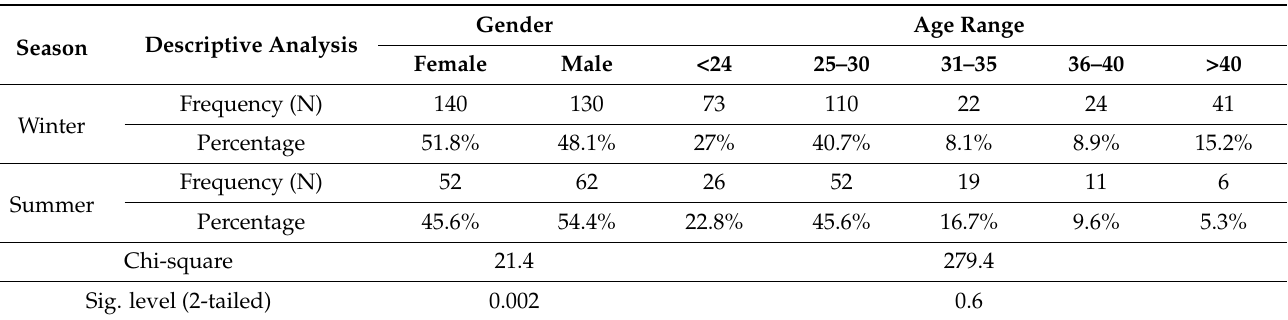
Table 3. Descriptive analysis of age and gender. The sampling distribution was equal between two groups of men and women. Chi-square test showed that there is no significant relation between respondents’ age and gender ( p = 0.24, ( p > 0.05)).